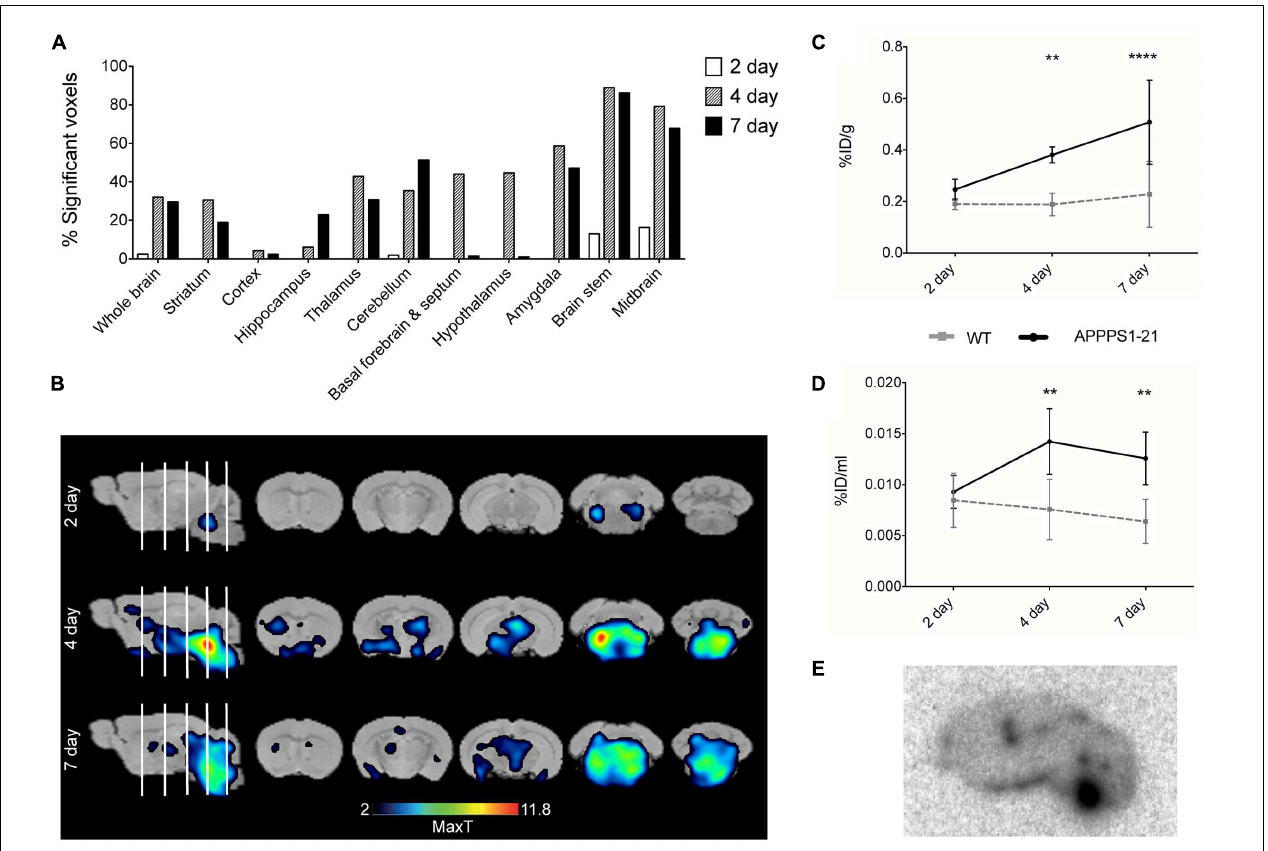
FIGURE 2 | Voxel-wise analysis of the µ PET data and ex vivo examination of brain tissue confirms higher accumulation of [ 89 Zr]-Df-Bz-JRF/A β N/25 in APPPS1–21 mice. Graph (A) shows voxel-wise analysis, data is presented as the percent of each brain region that was significantly changed (increase). This data is illustrated in image (B) , the statistical T-maps represent areas of significant increases. After imaging mice were sacrificed and brain radioactivity was measured ex vivo by (C) γ –counting and (D) autoradiography. Data is presented as the average + SD. (E) Representative autoradiograph of [ 89 Zr]-Df-Bz-JRF/A β N/25 uptake at 4 days pi in an APPPS1–21 mouse. Student’s t -test ∗∗∗∗ p < 0.0001, ∗∗ p < 0.01.